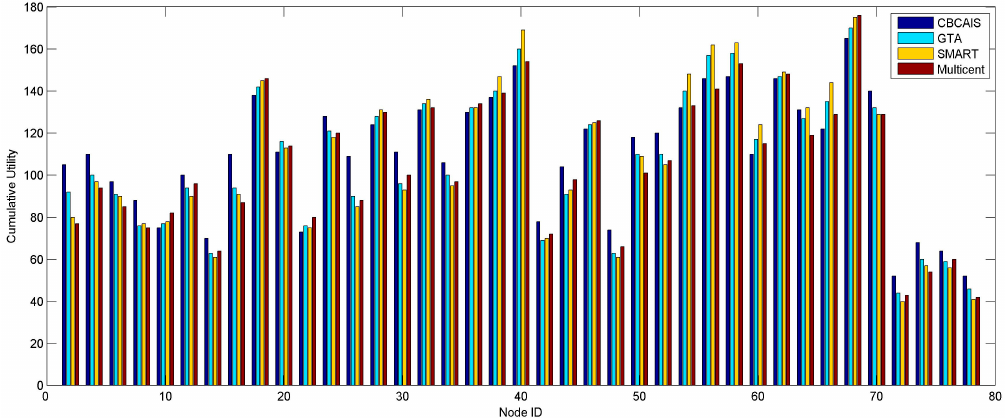
Figure 7. Cumulative utility comparison.